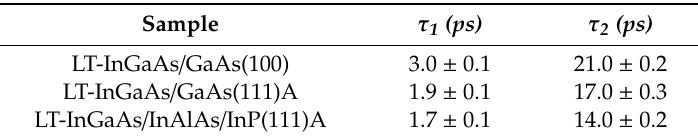
Table 2. Characteristic relaxation